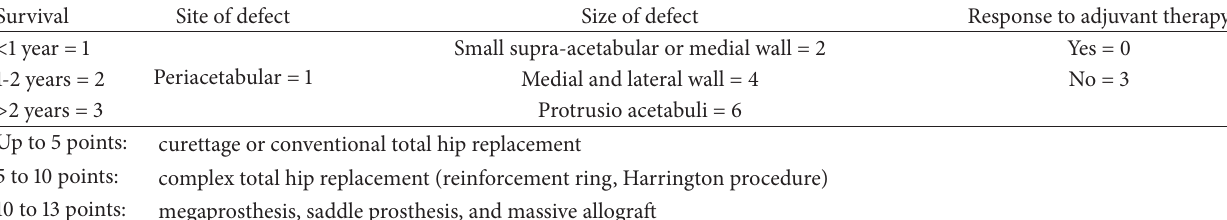
Table 3: Scoring system and recommended treatment for pelvic metastasis in patients of classes 2 and 3.